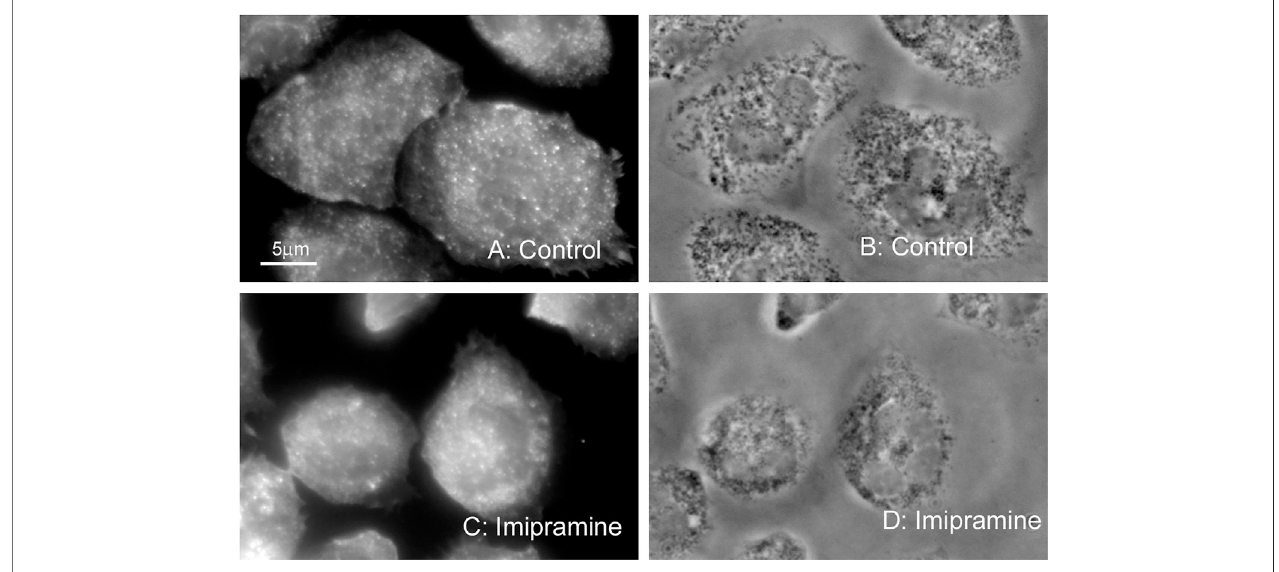
FIGURE 2 | Effect of imipramine on the actin cytoskeleton of neutrophils attached to a fi bronectin-coated substrate. Fluorescent (A, C) and phase contrast (B, D) images of neutrophils attached to fi bronectin-coated substrates under control conditions (A, B) or in the presence of 100 μ M imipramine (C, D) for 20 min at 37 ° C. Neutrophils were stained for actin with phalloidin FITC. Images are typical images observed in three independent experiments.